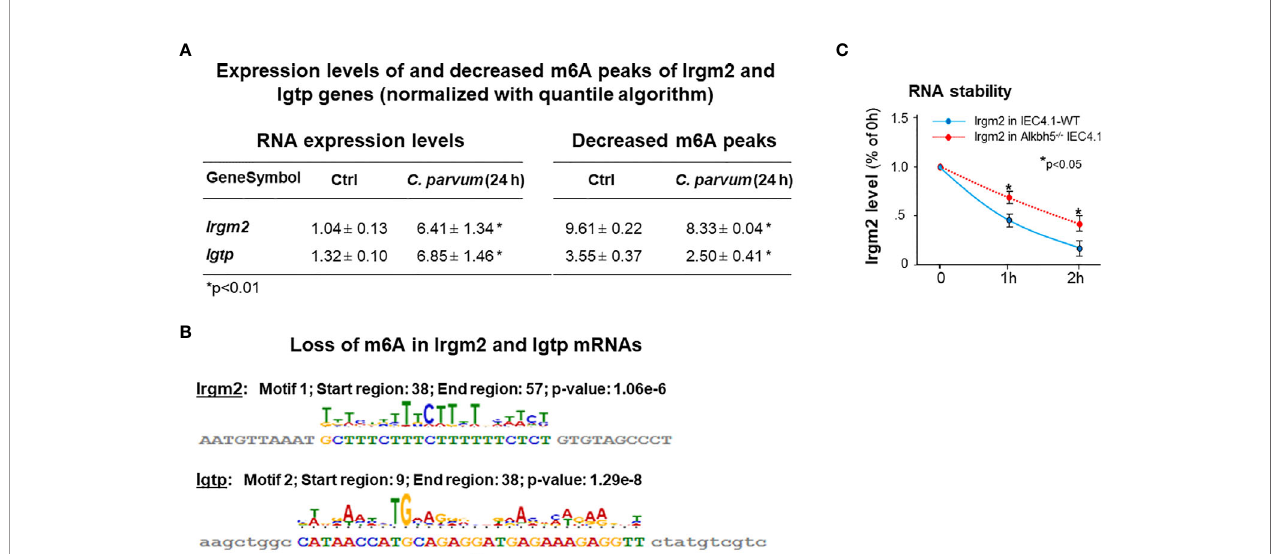
FIGURE 7 | Expression levels of Irgm2 and Igtp are increased and with a decreased m 6 A methylation in IEC4.1 cells following C. parvum infection. (A) Increased expression levels of both Irgm2 and Igtp genes with a decreased m 6 A peaks in their mRNAs in IEC4.1 cells following C. parvum infection. RNA levels of Irgm2 and Igtp and their m 6 A levels were assessed by RNA-Seq and m 6 A-RIP-Seq, respectively. (B) Decrease in their m 6 A levels in cells following C. parvum infection occurred in the promoters/UTRs/CDS regions. (C) Increased RNA stability of Irgm2 mRNA in Alkbh5-/- IEC4.1 cells versus that in IEC4.1 cells. Data represent three independent experiments. *p<.05 vs the non-infected control or cells transfected with the empty-vector control (as IEC4.1-WT in C